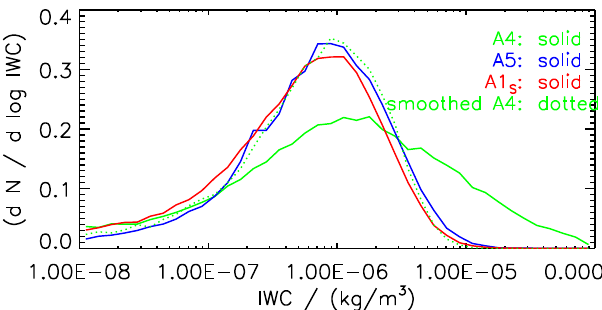
Table 3. Parameter settings in the box model study of Sect. 3.1: